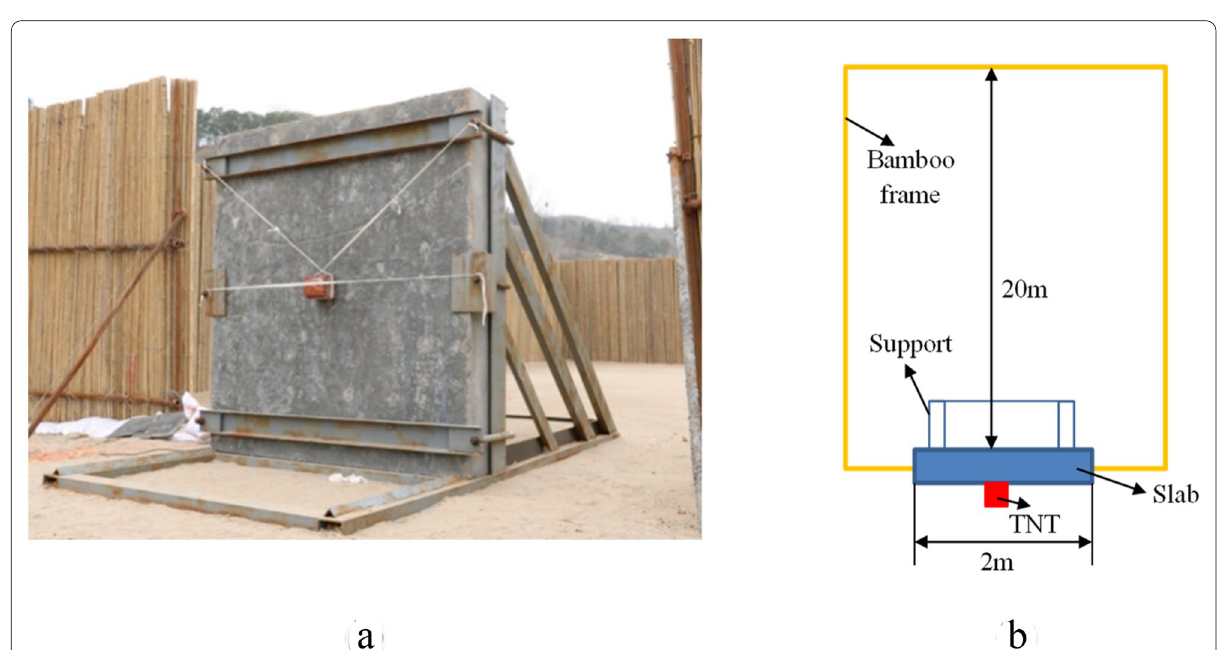
Fig. 7 Schematic diagram of explosion